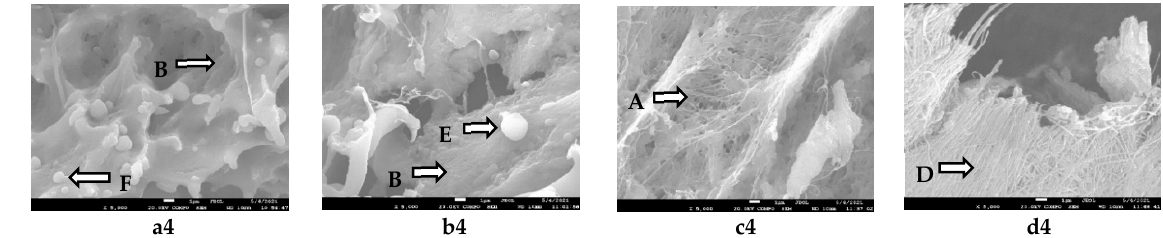
Figure 6. SEM microscopic structure of broiler chicken gizzards hydrolysates: ( a ) control sample at the start of hydrolysis; ( b ) control sample at the end of hydrolysis; ( c ) hydrolyzed test sample with Propionix LCSC, ( d ) hydrolyzed test sample with BLC; A: fibrous structure of the matrix, B: uniform and dense matrix surface, D: thin fibrils, E: mineral components of whey, F: globular proteins; magnification: (1)×200, (2) ×500, (3) ×1000, (4) ×5000.